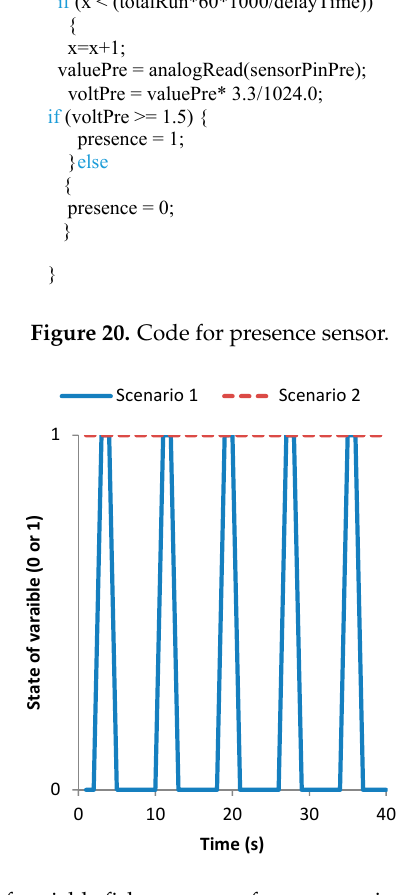
Figure 21. State of variable fish presence of one sensor in different scenarios.